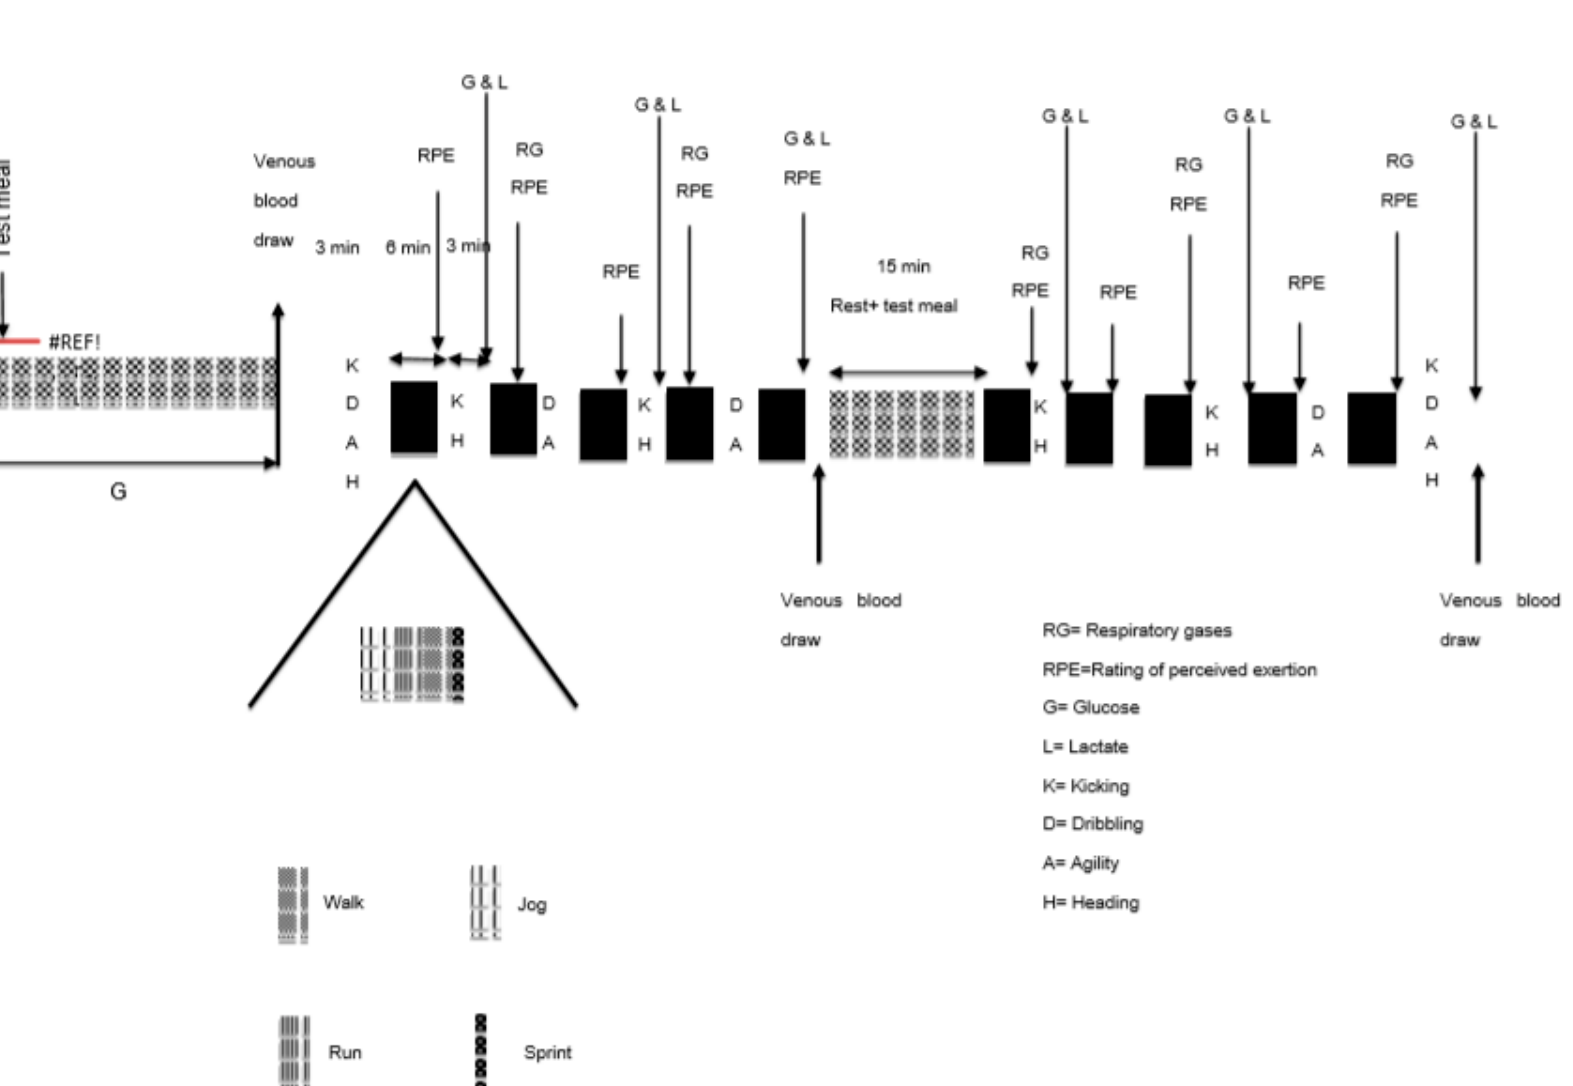
Figure 1. Schematic of the simulated soccer match. “#REF” denotes fingertip blood collection time points for glucose.